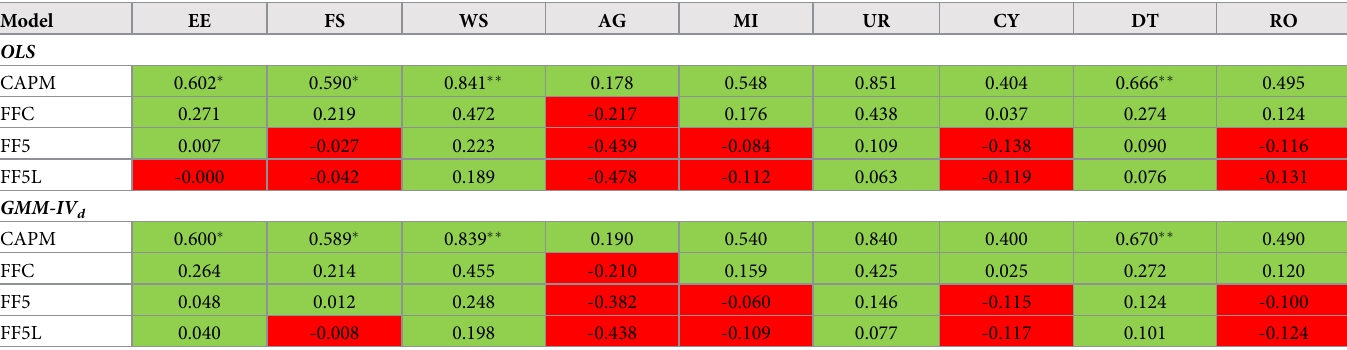
Table 6. Summary of alphas via OLS and GMM-IV d